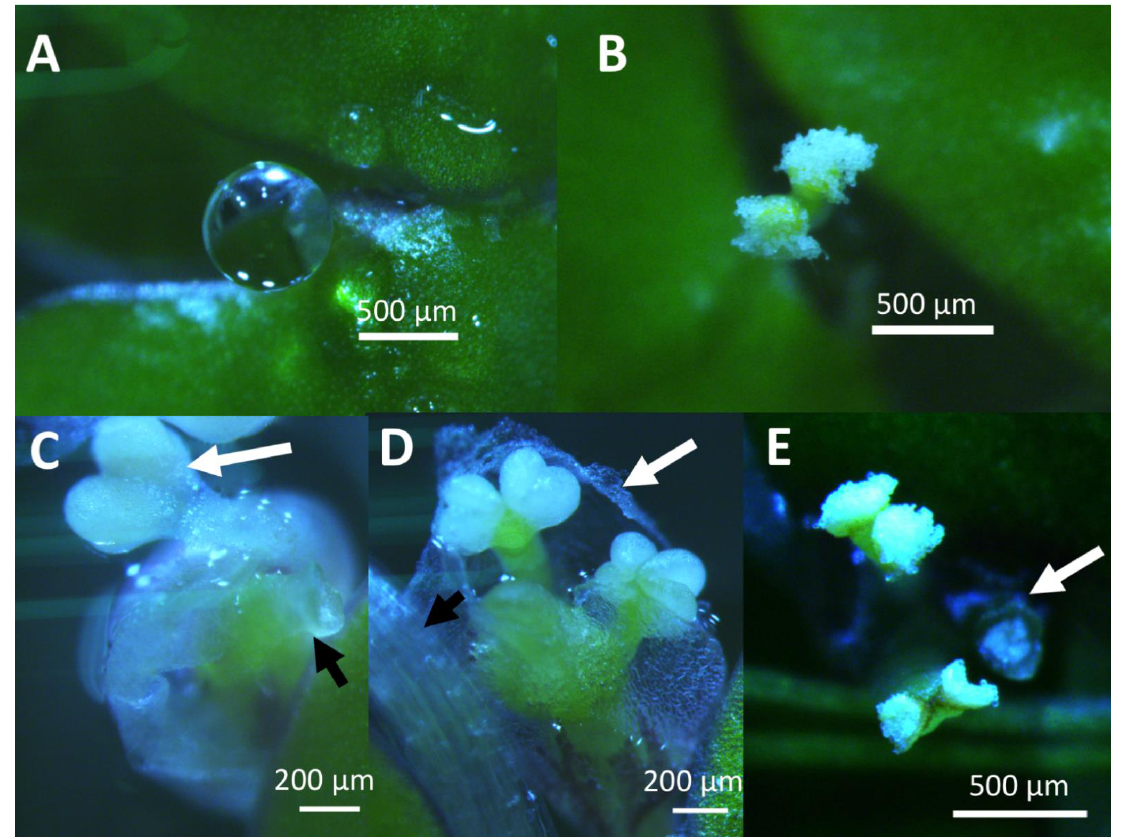
Figure 2. Flowers of S. polyrhiza strains 7498 and 9509. ( A ) Droplet of stigmatic fluid secreted by an S. polyrhiza 7498 pistil. ( B ) Dehiscing anthers of strain 7498. ( C ) Pistil without stigmatic fluid (black arrow) and non-dehiscent anther (white arrow) of S. polyrhiza strain 9509. ( D ) Two bi-lobed developing anthers and developing pistil of a strain 9509 flower. The transparent membrane known as a spathe (white arrow) has ruptured, but still surrounds the developing flower. The black arrow indicates a stipe, which connects the mother frond to a daughter. ( E ) Dehiscing anthers of strain 9509 and pistil without stigmatic fluid (white arrow). Occasionally, abnormal flowers were seen in Petri dish cultures. Unusual kidney